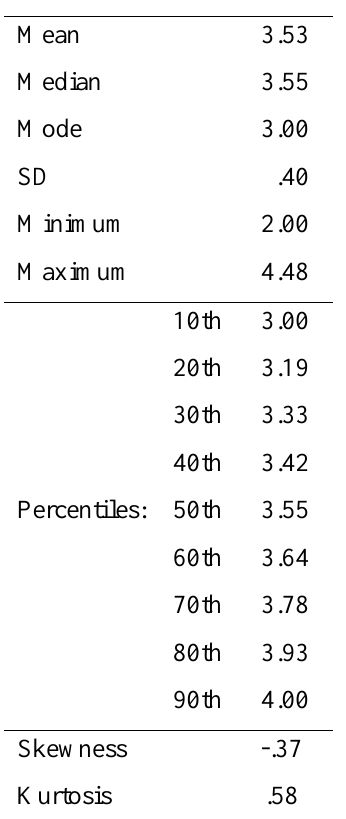
Descriptive Statistics: Average Scale Rating Across All